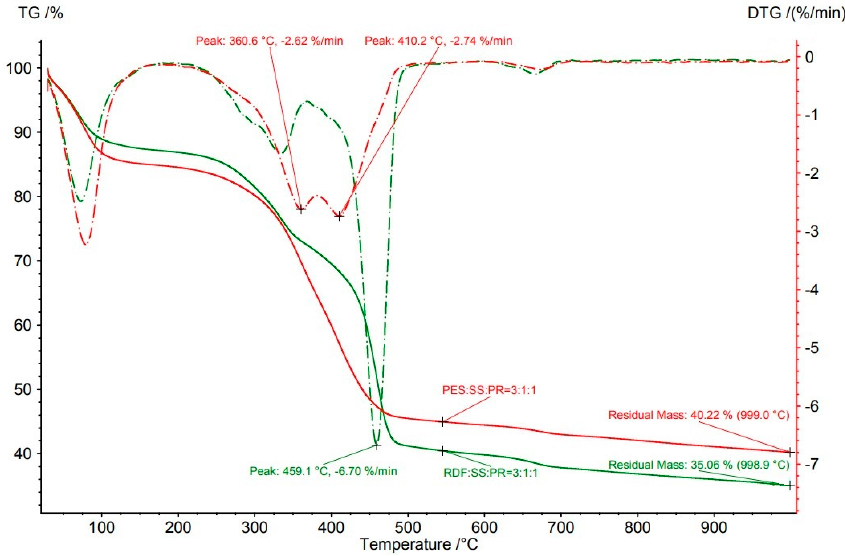
Figure 11. TG/DTG curves of LDPE:SS:PR in 2 different volume ratios. The TG curves for the PES:SS:PR and RDF:SS:PR samples are similar up to a temper- ature of approx. 300 °C (Figure 12). The sample containing PES decomposes at two tem- peratures for a temperature range of approx. 300–500 °C, while the RDF sample decom- poses in a narrow temperature range of 400–500 °C.